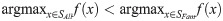
Best fit to data was obtained under SAll.Comparison of the RMSE produced by the Artificial Anasazi model when agents had full information (SAll), information through family households (SFam), information through the households with most agricultural success (SPerf), or information through neighboring households (SNeigh). Models that used SAll produced the lowest RMSE overall argmaxx∈SAllf(x)<argmaxx∈SFamf(x) (p = 2.045 × 10−113), argmaxx∈SAllf(x)<argmaxx∈SNeighf(x) (p = 4.856 × 10−154), argmaxx∈SAllf(x)<argmaxx∈SPerff(x) (p = 1.983 × 10−57).